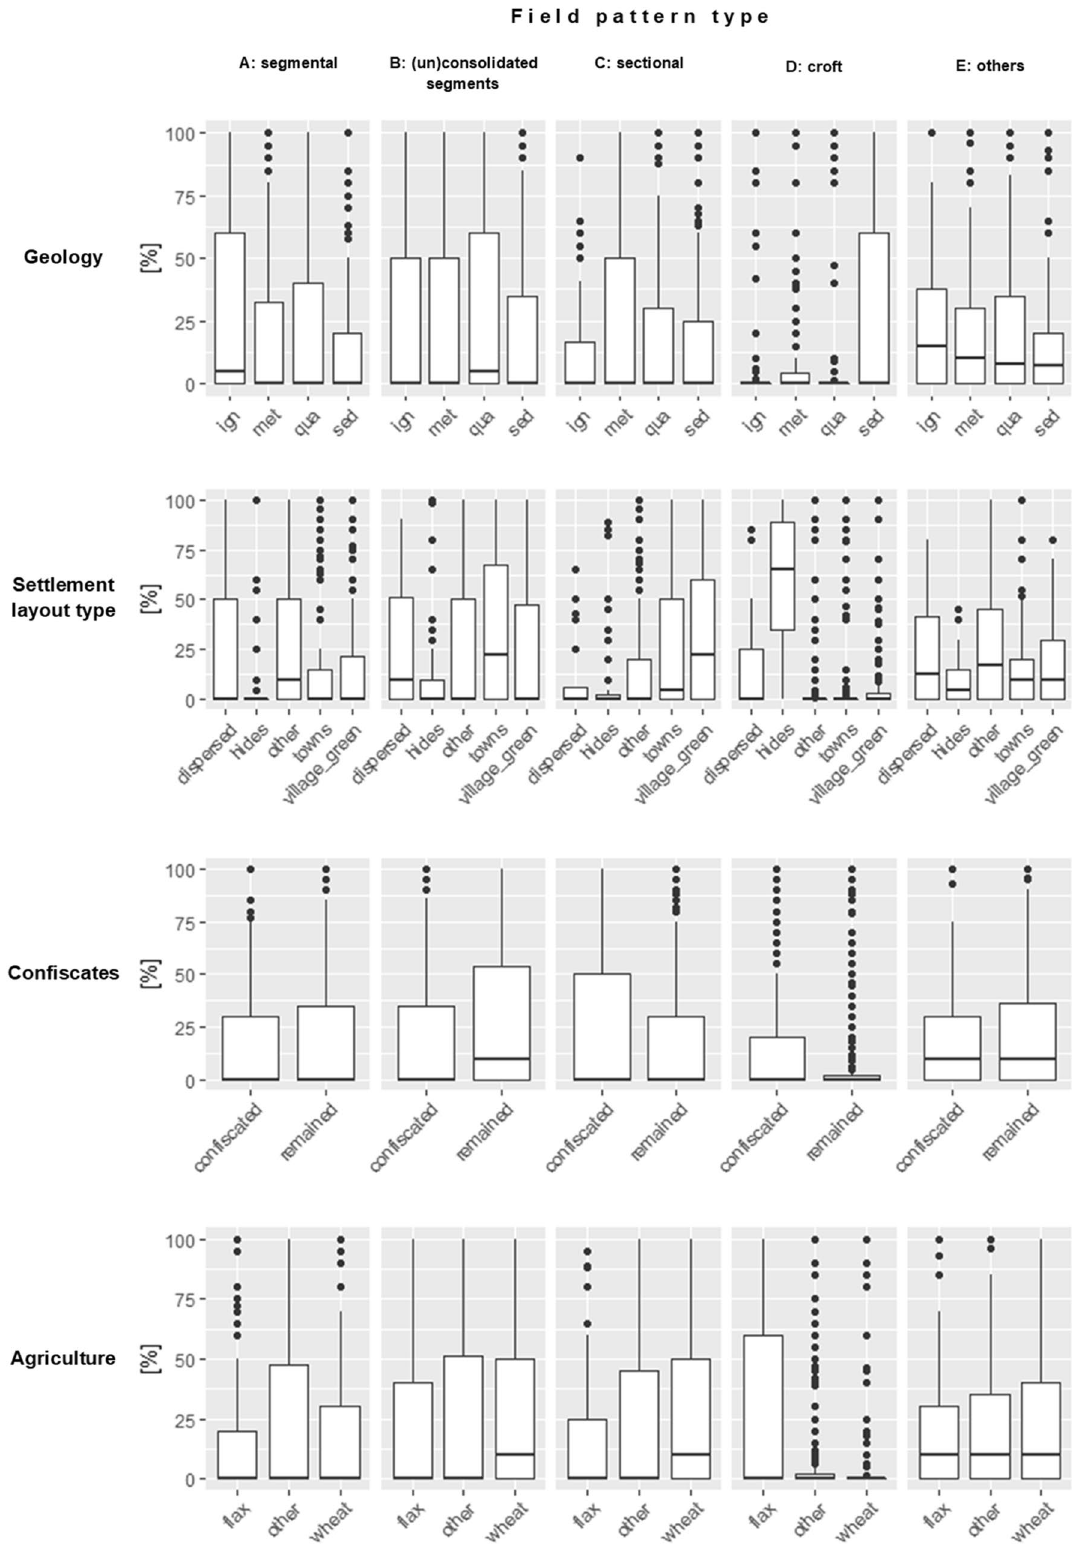
Figure 3. Influence of categorical variables. The percentages refer to the proportion of the specific field pattern type in the examined cadastres. The descriptions of variables of the x-axes are on the left side of the respective